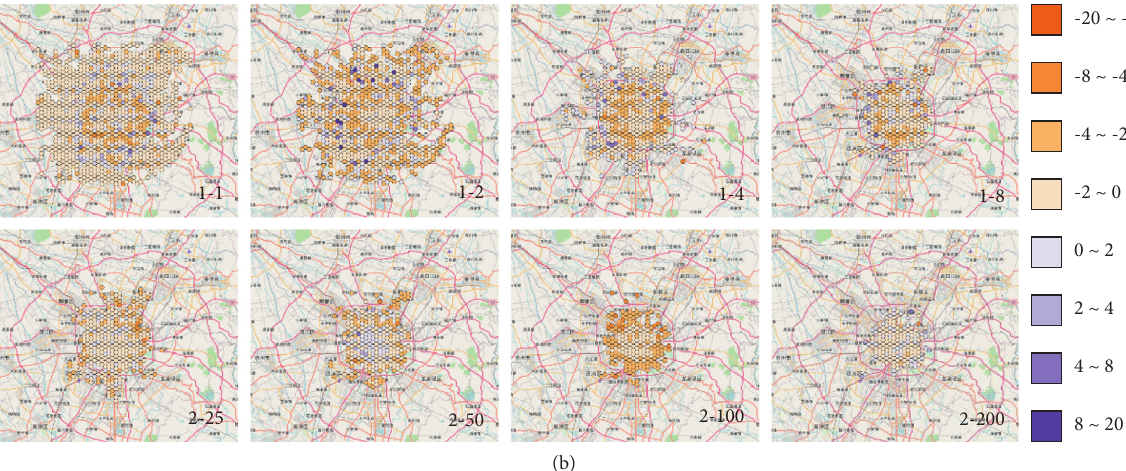
Figure 7: Spatial distribution of SMAPE difference between H-ConvLSTM and other models: (a) H-CNN-LSTM; (b) H-CNN-GRU.